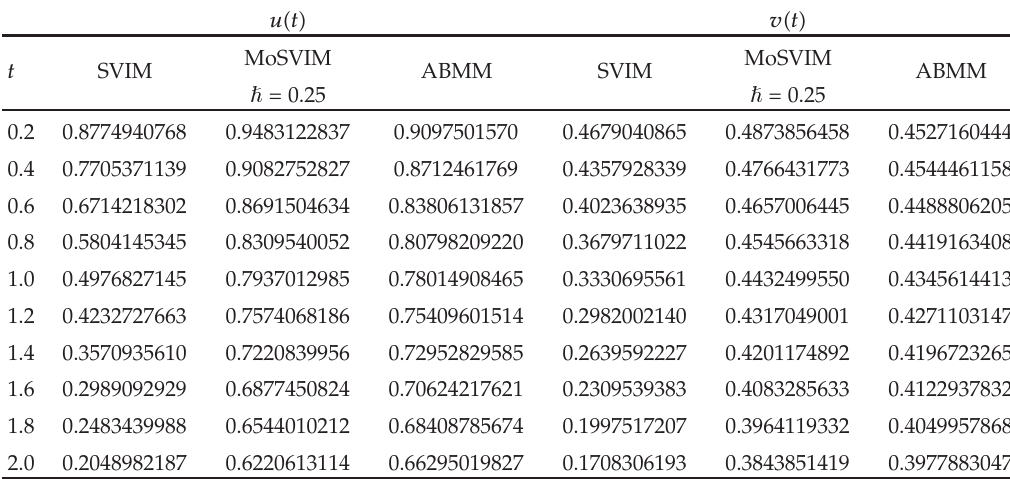
Table 2: Approximate solution of fractional biochemical reaction model for θ (cid:9) 0 . 8 , iterate of SVIM and MoSVIM, respectively, and ABMM in comparison with Δ t (cid:9) 0 .